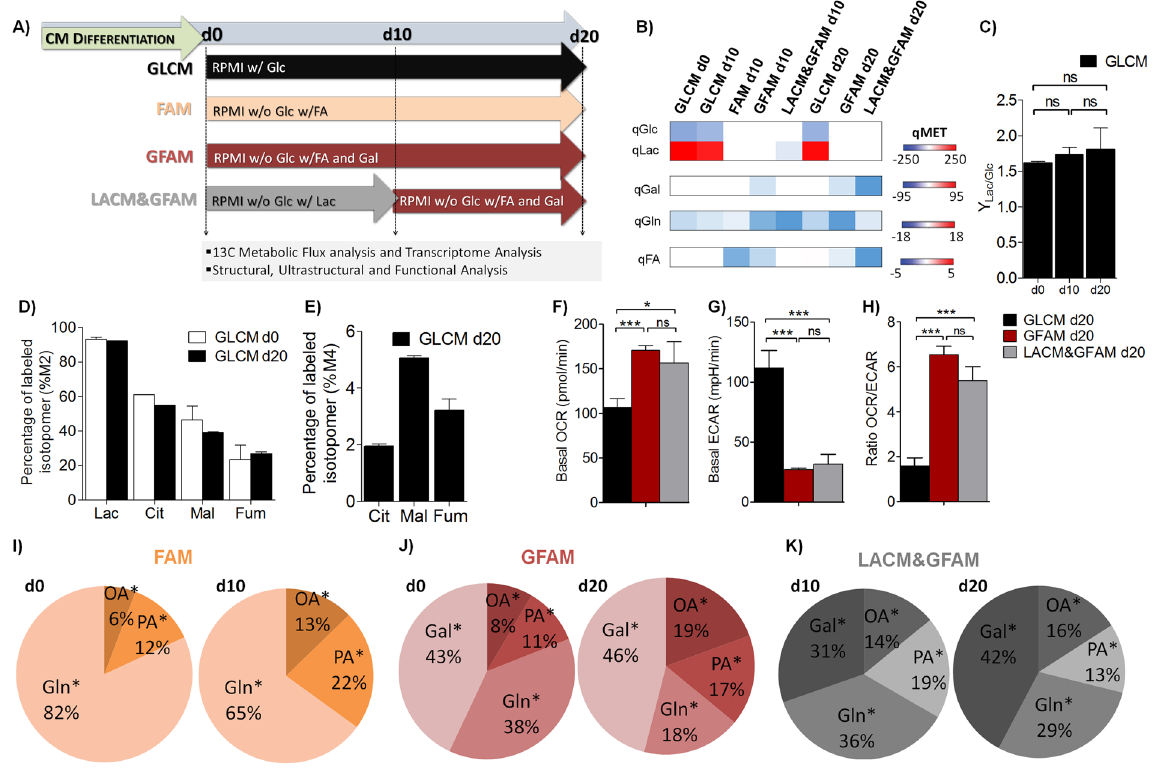
Figure 1. Effect of culture medium composition on central carbon metabolism of hiPSC-CMs. ( A ) Representative scheme illustrating the experimental set-up. The metabolome of hiPSC-CMs was evaluated before (d0) and after 10 (d10) and 20 days (d20) of culture in different media: GLCM (black), FAM (Orange), GFAM (Red) and LACM&GFAM (Grey). ( B ) Heatmap image of metabolome data illustrating specific consumption (blue) and production (red) rates of metabolites (qMET; nmol/(10 6 cell.h)). ( C ) Ratio of Lac production to Glc consumption (YLac/Glc) in GLCM through culture time. ( D ) Percentage of labelled M2 isotopomers from [1,2- 13 C]Glc in Lac and in TCA intermediates (Cit, Fum, Mal). ( E ) Percentage of labelled M4 isotopomers from [U- 13 C]Gln in TCA intermediates. M2 and M4, reflect the first round of TCA cycling of [1,2- 13 C]Glc and [U- 13 C]Gln, respectively. ( F ) Basal oxygen consumption rate (OCR). ( G ) Extracellular acidification rate (ECAR). ( H ) OCR/ECAR ratio reflecting the relative contribution of OXPHOS over glycolysis for energy generation. ( I – K ) Pie charts indicating the contribution of the main substrates of each media, for TCA cycle pools. The percentages were determined based on the incorporation of each labelled substrate in Cit, Fum and Mal. OA: Oleic Acid and PA: Palmitic acid. Data are represented as mean ± SD of 12–24 wells, n ≥ 3 separate experiments. * p < 0.05; *** p < 0.001; ns, not